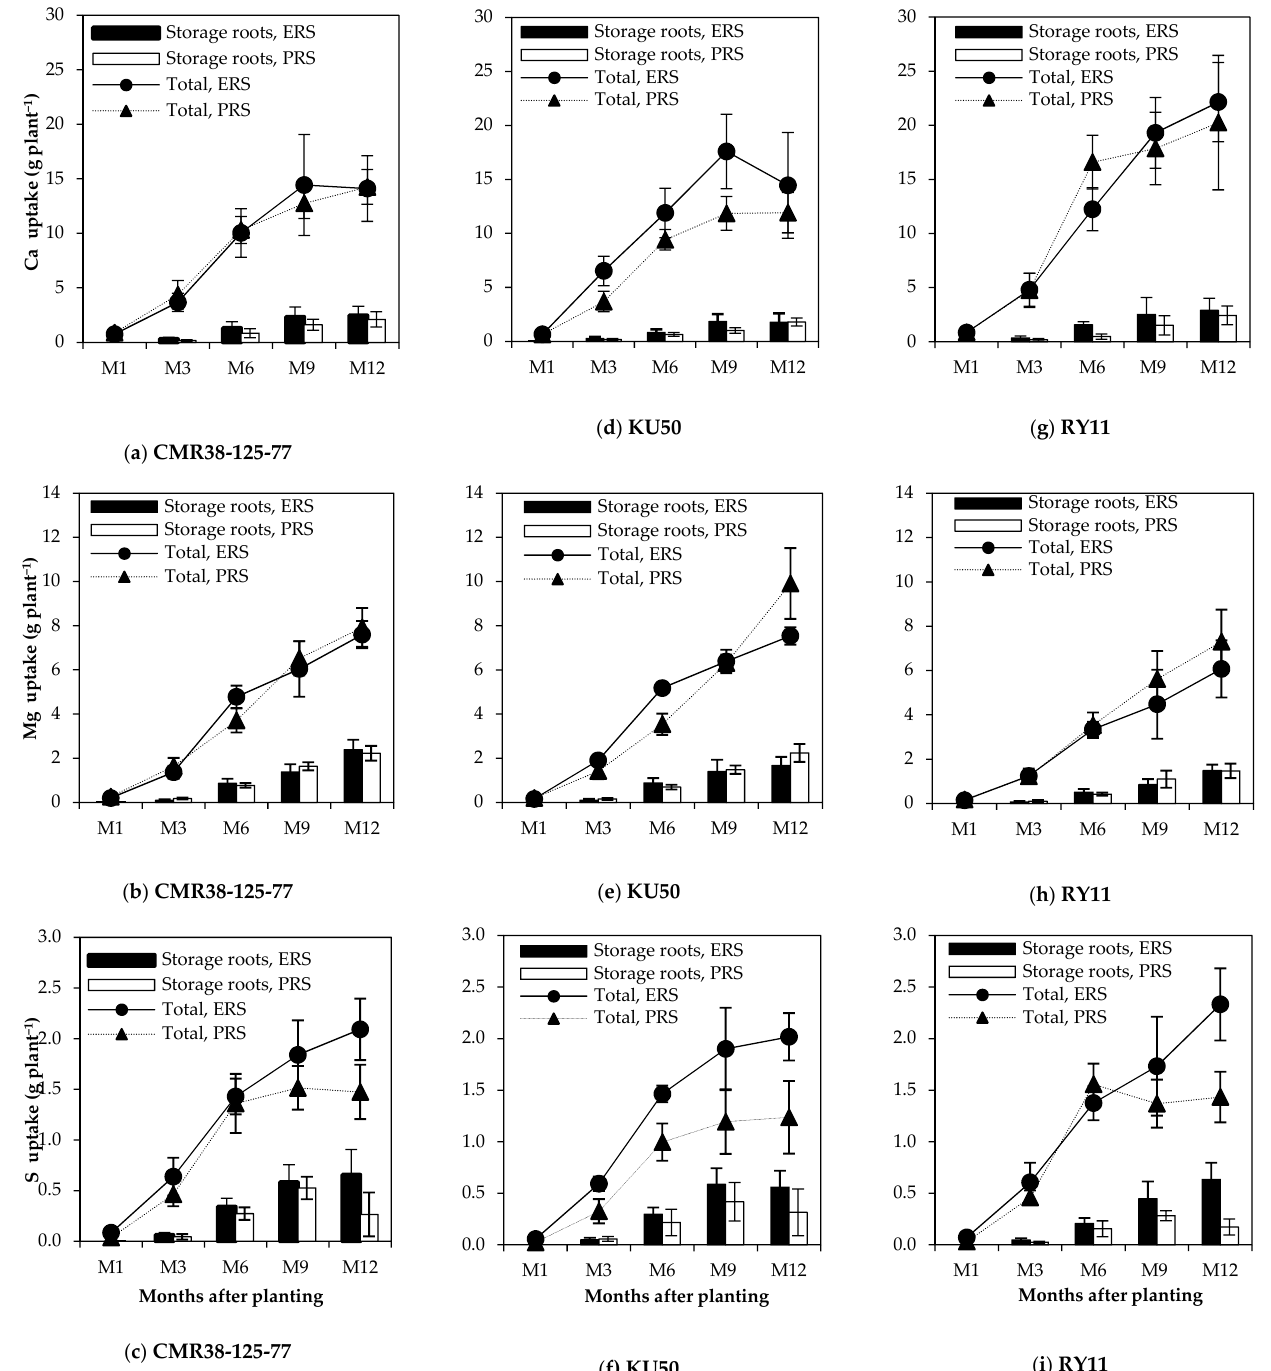
Figure 3. ( a – i ) Total calcium, magnesium and sulfur accumulation and their accumulation in the storage roots (g plant − 1 ) of three cassava genotypes in the early rainy season (ERS) and post rainy season (PRS) with full irrigation. Each point represents the mean, and bars show standard deviation (n = 4). Ca = calcium; Mg = magnesium; S = sulfur; KU50 = Kasetsart 50; RY11 = Rayong 11.